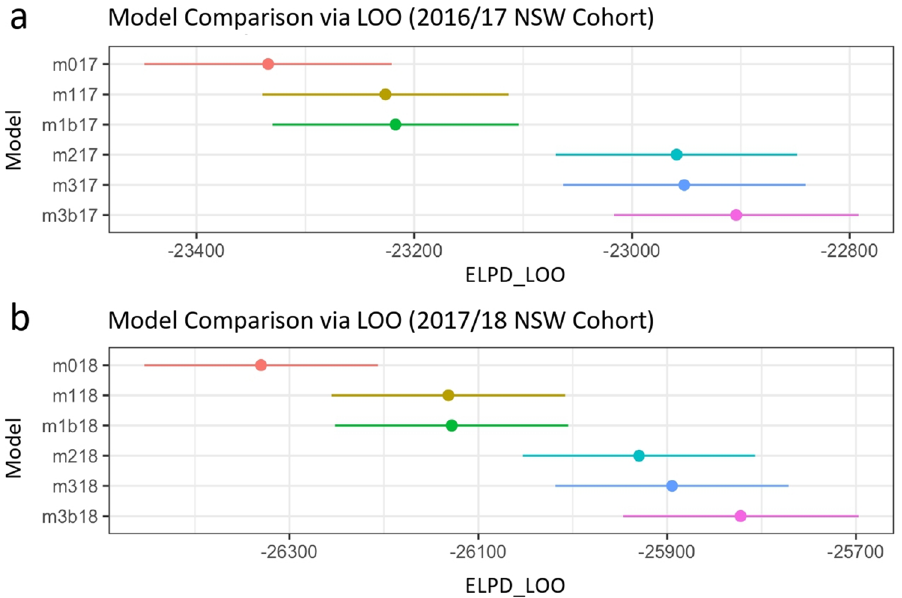
Figure 5. Model comparison (models 1-6) for 2016/17 ( a ) and 2017/18 ( b ) NSW cohorts. In both analyses, model m0 included an overall intercept; model m1 added a linear age term; model m1b added a quadratic age term; model m2 added a predictor for loneliness type (social vs emotional); model m3 added a linear age * loneliness type interaction; model m3b (the full model) added a quadratic age * loneliness type interaction. “ELPD_LOO” refers to the estimate of the expected log pointwise predictive density. “LOO” refers to leave-one- out estimated cross validation. Error bars depict the standard error of the mean. The “17” and “18” suffixes in each model indicate the 2016/17 and 2017/18 NSW cohorts,